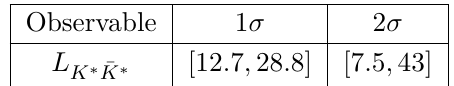
Table 1 . 1 σ and 2 σ confidence intervals for the SM prediction of L the ratio | P /P | , which we can attempt to estimate in different ways. A naive SU(3) s d approach would consist in